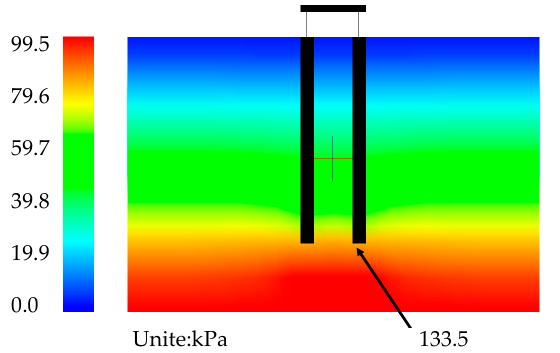
Figure 9. Distribution of initial effective stress in vertical direction in the ground.